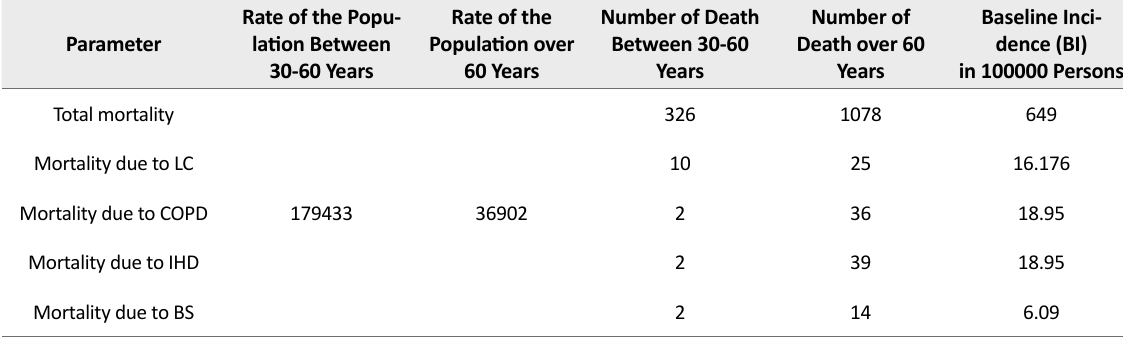
Table 4. The estimated rate of death, diseases, and baseline incidence Baseline Inci - Number of Number of Death Rate of the Rate of the Popu - dence (BI) Death over 60 Between 30-60 Population over Parameter lation Between in 100000 Persons Years Years 60 Years 30-60 Years Total mortality 326 1078 649 Mortality due to LC 10 25 16.176 179433 36902 Mortality due to COPD 2 36 18.95 Mortality due to IHD 2 39 18.95 Mortality due to BS 2 14